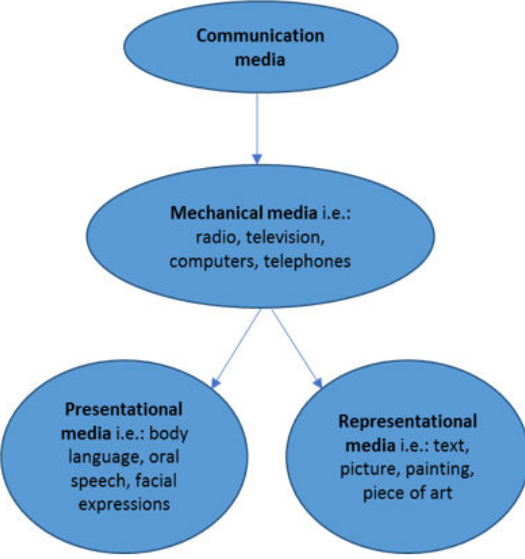
Figure 3. Concept map of communication